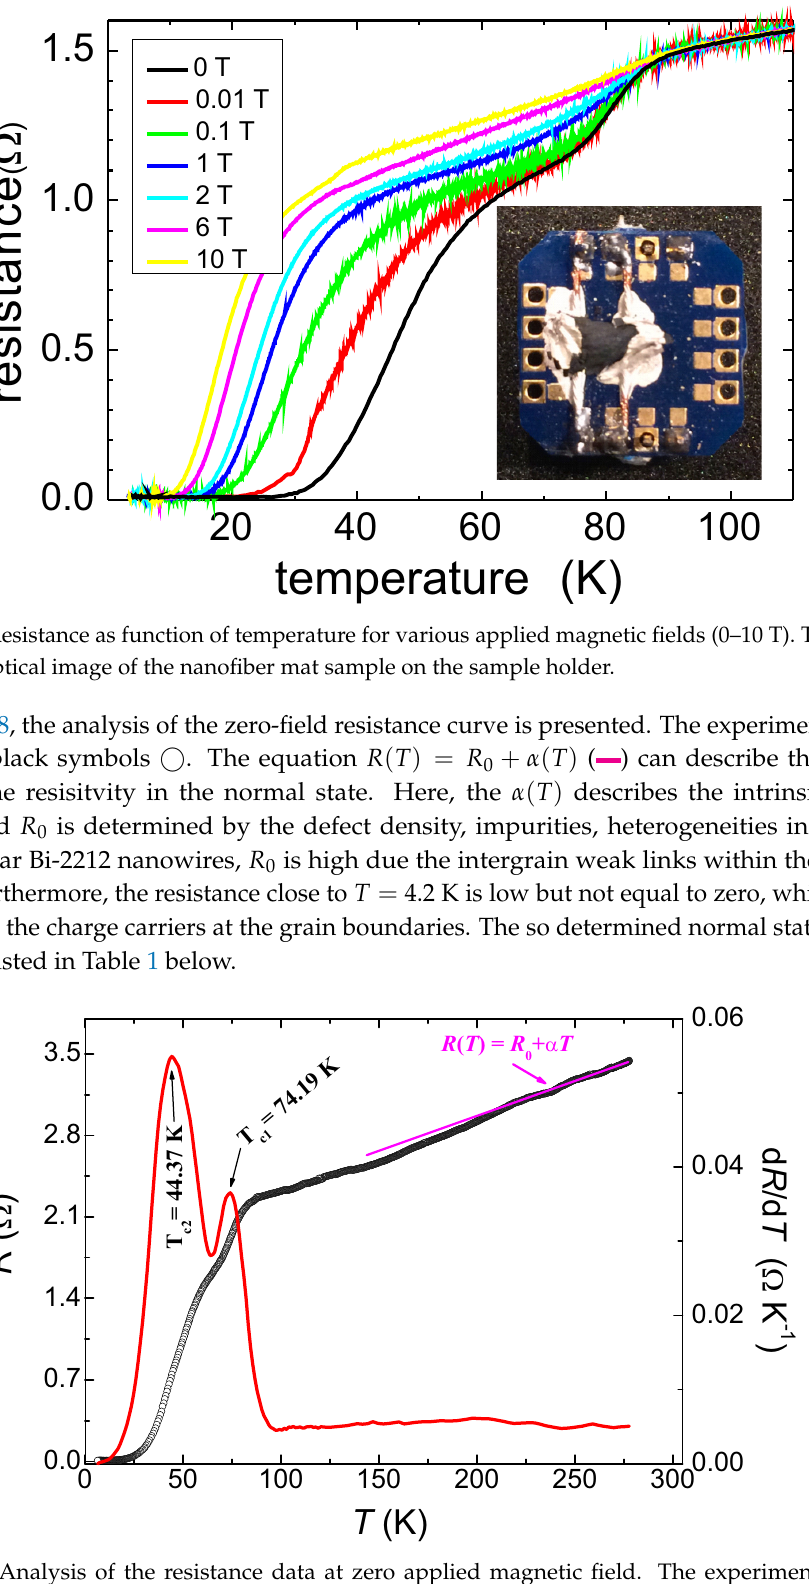
Figure 8. Analysis of the resistance data at zero applied magnetic field. The experimental data are indicated by open circles ( (cid:13) ). The derivative, d R /d T ( ), shows peaks for two transitions at temperatures, T c 1 and T c 2 . The linear fit ( ) to the data serves for the determination of α and R 0